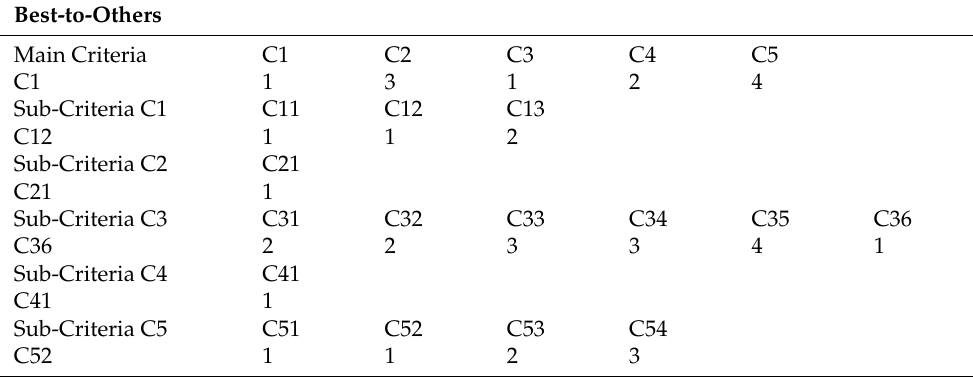
Table 4. Best-to-Others vectors obtained by the expert